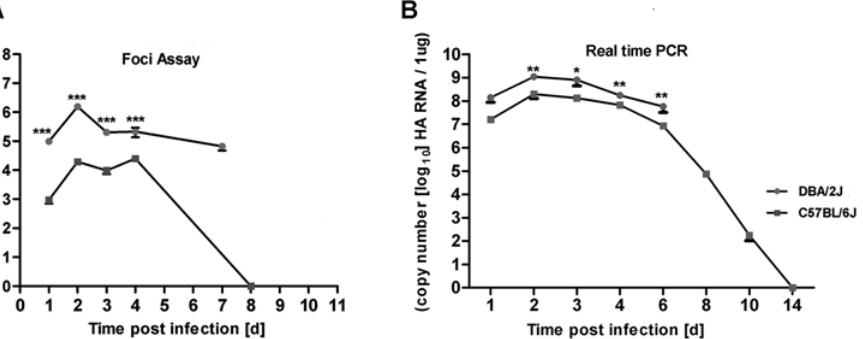
Figure 6. Higher viral load is detected in DBA/2J mice compared to C57BL/6J mice. DBA/2J and C57BL/6J mice were infected intra-nasally with 2 6 10 3 FFU and viral load was determined at the indicated times post inoculation for infectious particles measured by foci assay (A) or by copy number of viral hemagglutinin (HA) RNA (B). Mean + / 2 SEM are shown. For foci assay in (A), 9 DBA/2J mice were used at all time points, and for C57BL/6J, 6 mice were used at day1, 8 mice at day 2 and 9 mice at days 3, 4, and 8. For RNA assays in (B), 10 mice were used except 15 for day 4, and 5 for day 6. DBA/2J and C57BL/6J mice were compared for statistical significant differences using non-parametric Mann-Whitney-U-test. *: p value , 0.05; **: p , 0.01; ***: p value ,